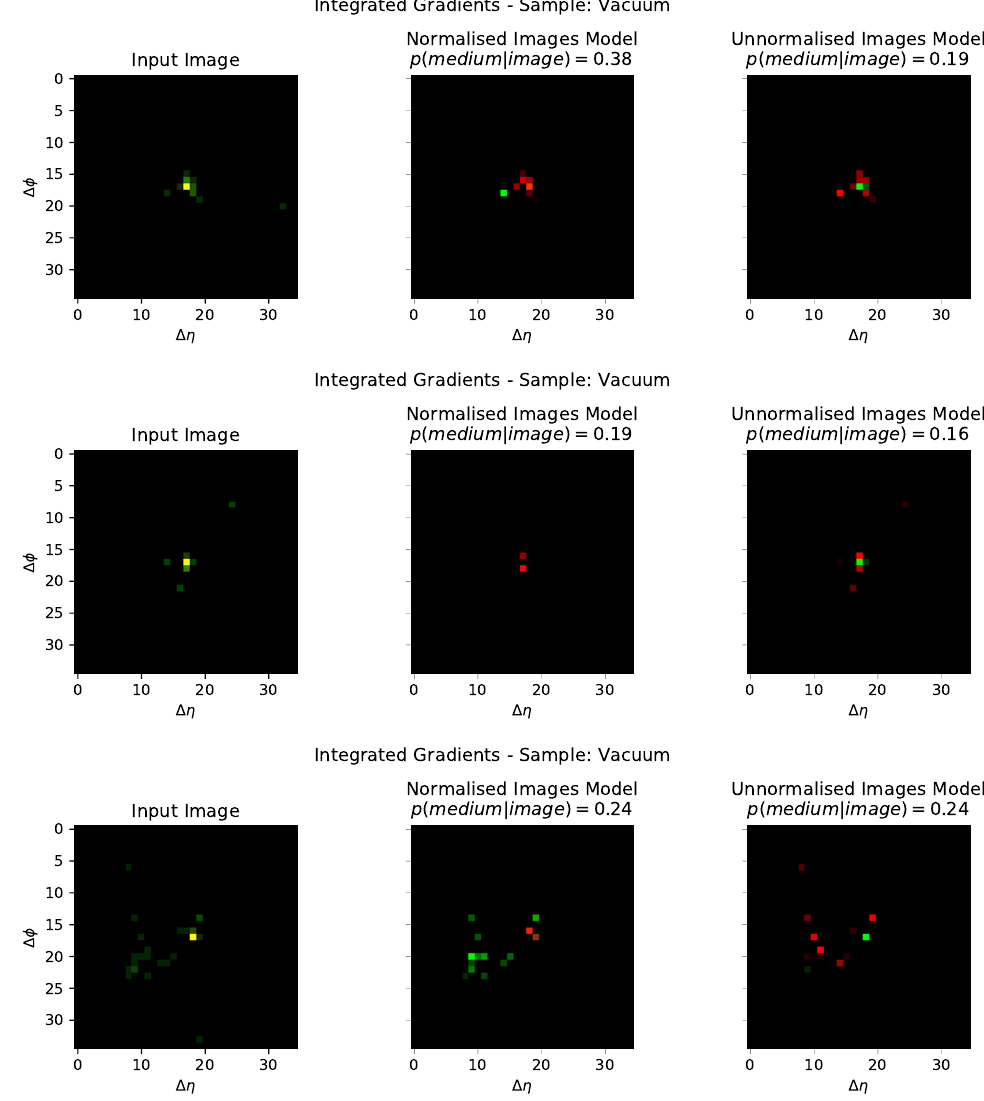
Figure 21 . Integrated gradients for some correctly classified vacuum sample